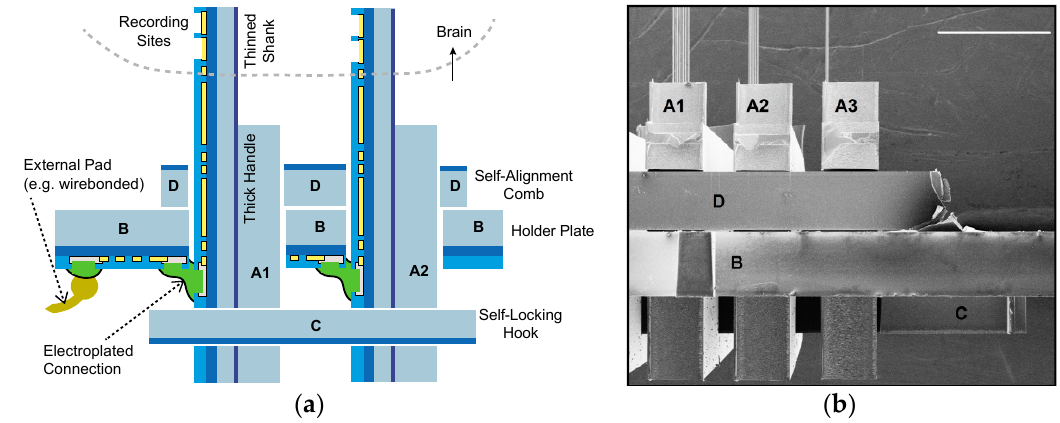
Figure 4. ( a ) Cross-section schematic of the assembled probe, with the different parts from Figure 3 labeled (drawing not to scale). ( b ) SEM image showing a close-up side-view of the probe in Figure 1, with the corresponding parts labelled. The scale bar is 1 mm. After completed assembly, the probe can subsequently be encapsulated in epoxy (not shown here), protecting the electroplated and external connections, while leaving the thinned shanks free from encapsulation (similar to how we epoxy-encapsulate our 2-D probes in [12]).